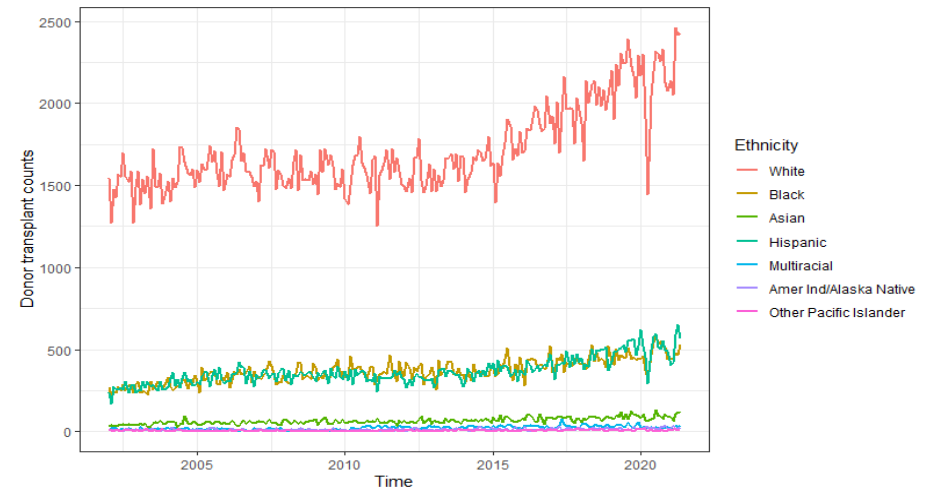
Figure 12. Donor transplant counts in the US across ethnicity, based on OPTN data as of November 2021.